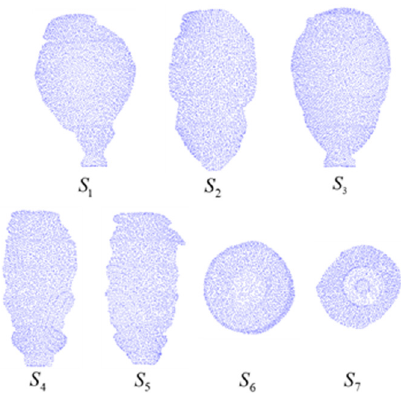
Figure 16. Partial point clouds of the hull ‘a’ at different scanning angles.